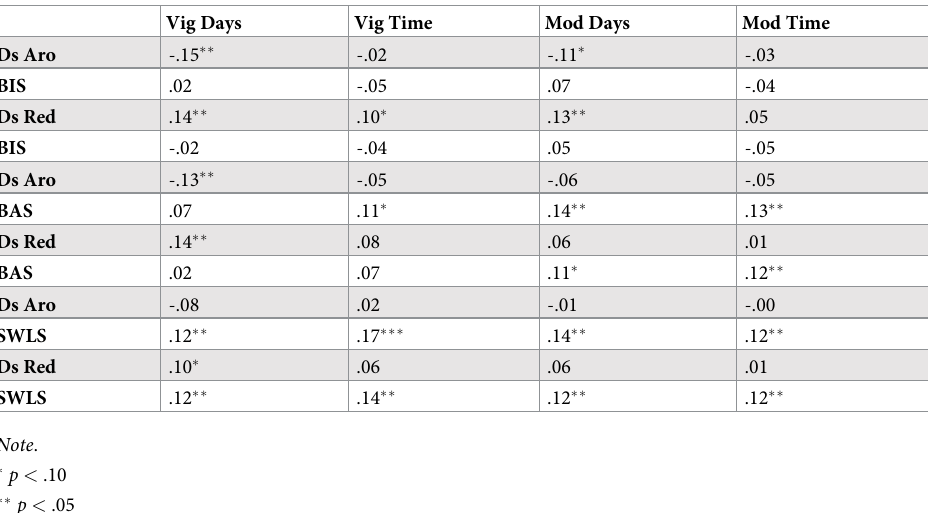
Table 17. Partial correlations of exercise variables with dissonance variables and BIS, BAS, and SWLS (the latter variables were simultaneous predictors; Study